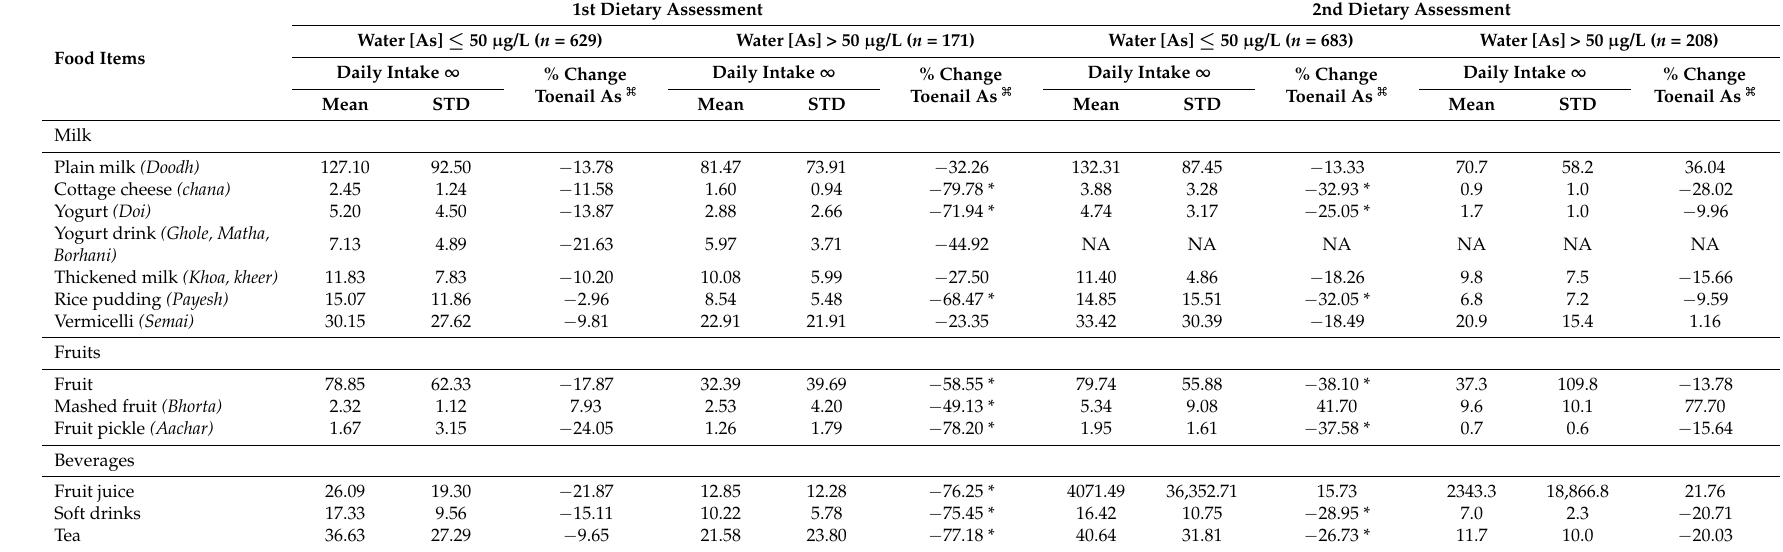
Table 2. Mean daily intake level for each food item and the percent change in toenail As concentration comparing the 5th to the 95th percentile of intake level. Food Items 1st Dietary Assessment